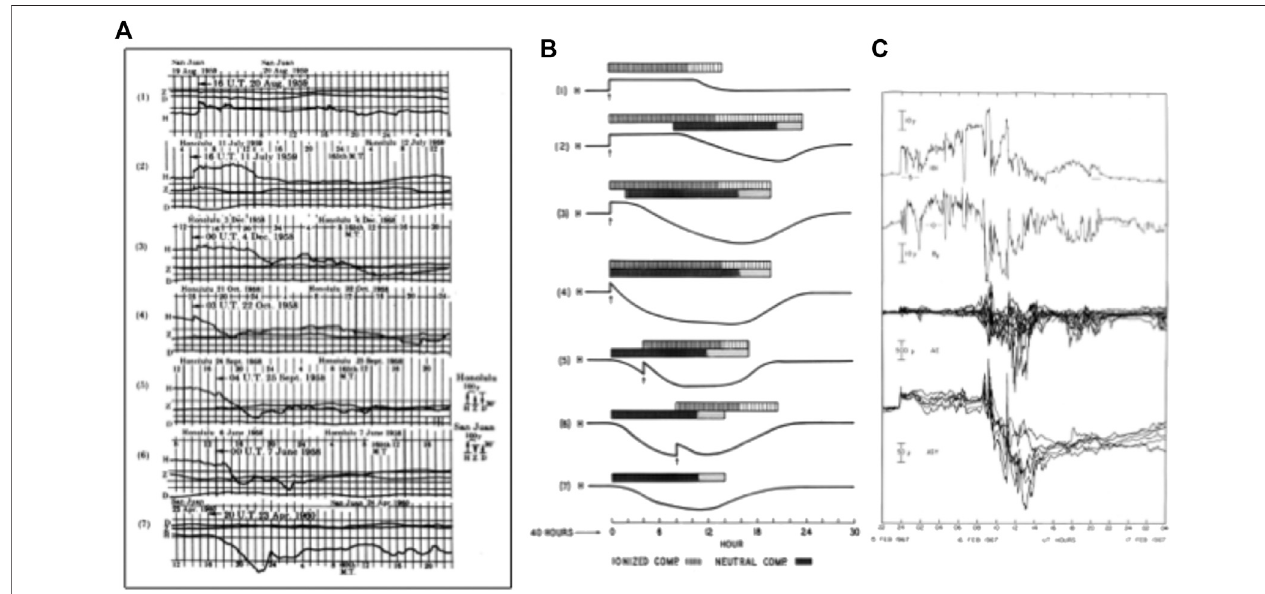
FIGURE 5 | (A) It shows a number of ways of the development, indicating that geomagnetic storms do not necessarily develop in the standard way. (B) The fi gure suggests that the variety of the development is caused by different combination of pure plasma (white bar: protons and electrons) and the “ unknown factor ” (black bar: initially considered to be atomic hydrogen atoms). An example of geomagnetic storms with the IMF magnitude B and the Bz component: it shows clearly that the development of the main phase depends on the IMF Bz